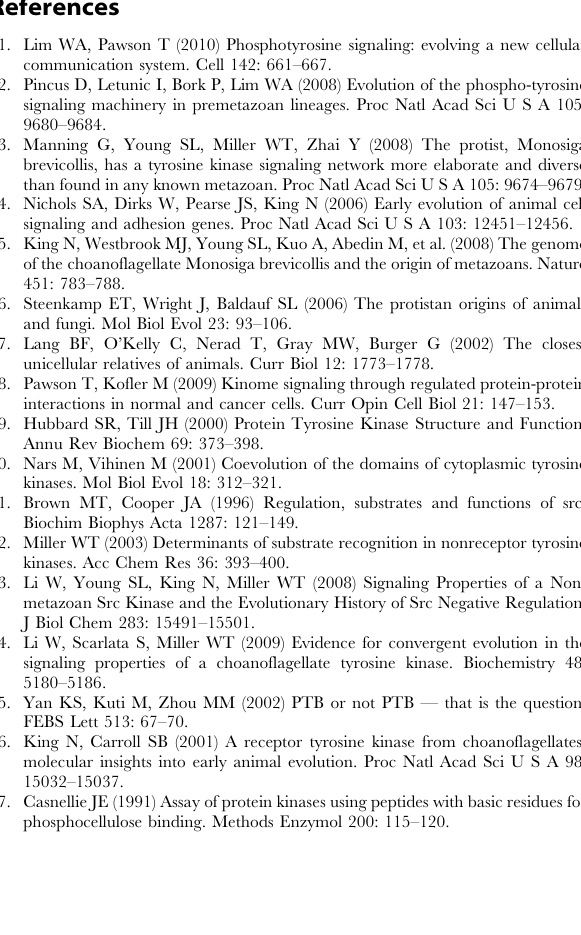
Figure S5 Immunoprecipitation experiment. HMTK1 (wild-type or mutants) was immunoprecipitated from SYF cells using anti-FLAG affinity resin. Proteins in the immunocomplexes were separated by SDS-PAGE and analyzed by Western blotting with anti-pTyr and anti-FLAG antibodies. The band at < 110